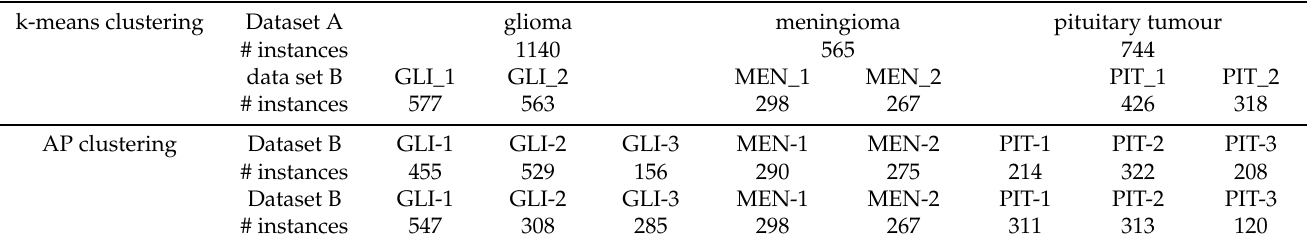
Table 6. The number of instances in original classes and after class decomposition of the brain tumour dataset using k-means and AP clustering algorithms.